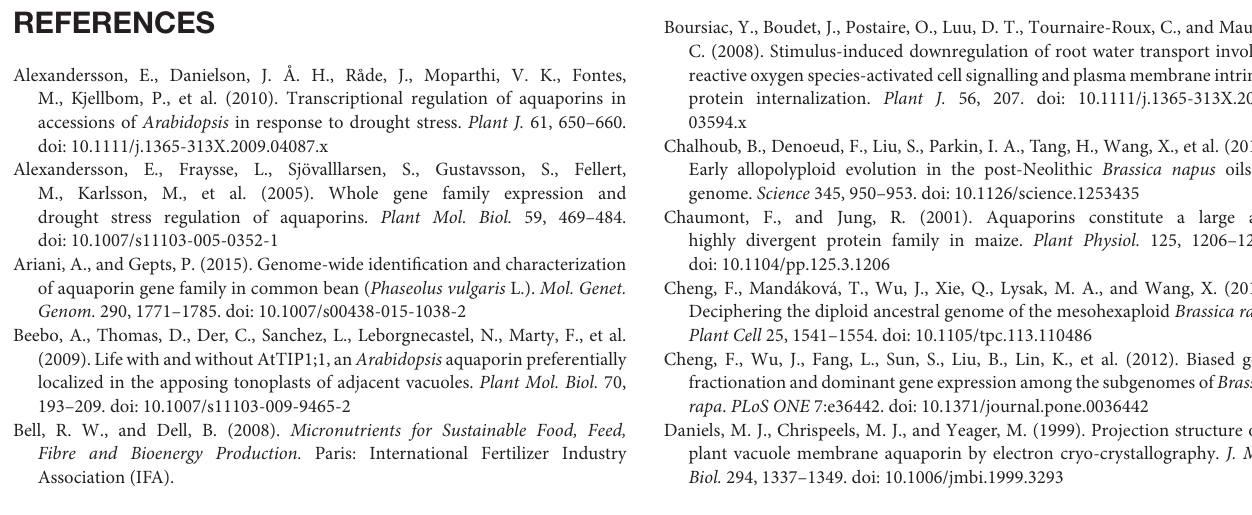
Supplementary Figure 1 | Putative MW and PI of BnaPIPs, BnaSIPs, BnaNIPs, and BnaTIPs in Brassica napus . The genes in the four sub-families were distinguished by different legends. Supplementary Figure 2 | WebLogo plot of the consensus motifs in BnaAQPs. The amino-acid residues of the consensus motifs in FASTA format were obtained from the MEME Web and WebLogo plot graphs were generated using the amino acid sequences, (A) Motif 1; (B) motif 2; (C) motif 4; (D) motif 5. Supplementary Table 1 | Gene location and description of incomplete BnaAQP s. Supplementary Table 2 | BnaAQP genes without chromosome localization information. Supplementary Table 3 | The RPKM values of the 121 BnaAQP